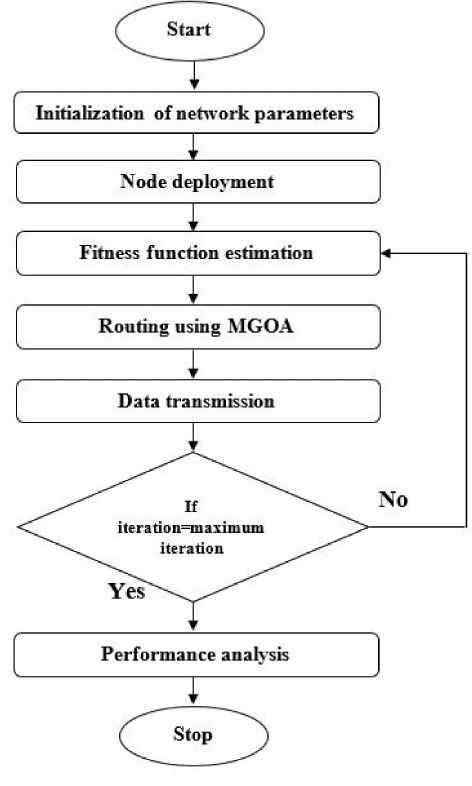
Figure 2. Workflow of MGOA ‐ WAVLCN.